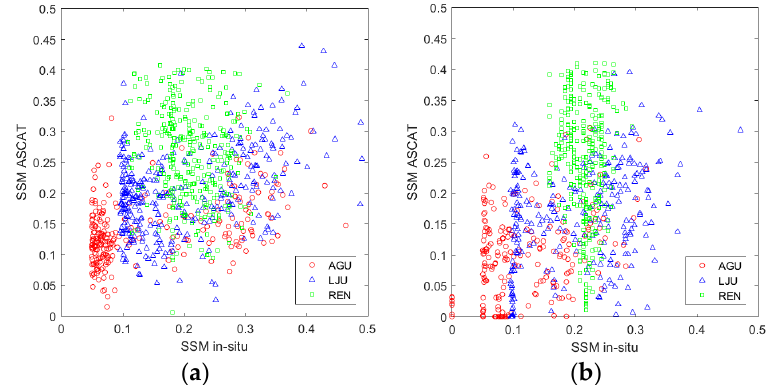
Figure 1. Scatter diagram of in situ and predicted SSM from ASCAT for the different land cover types in EUROPE, for year 2010 ( a ) and 2011 ( b ).